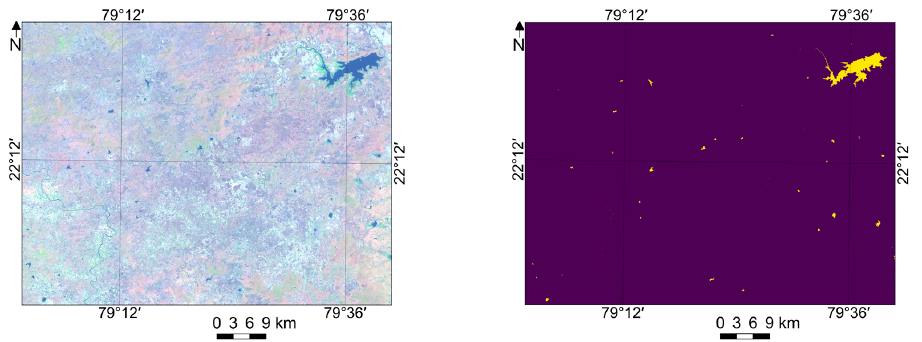
Figure B6. Water/non-water region estimation using Landsat-8 image collected on 2014-04-16. Figure A6. Water/non-water region estimation using Landsat-8 image collected on